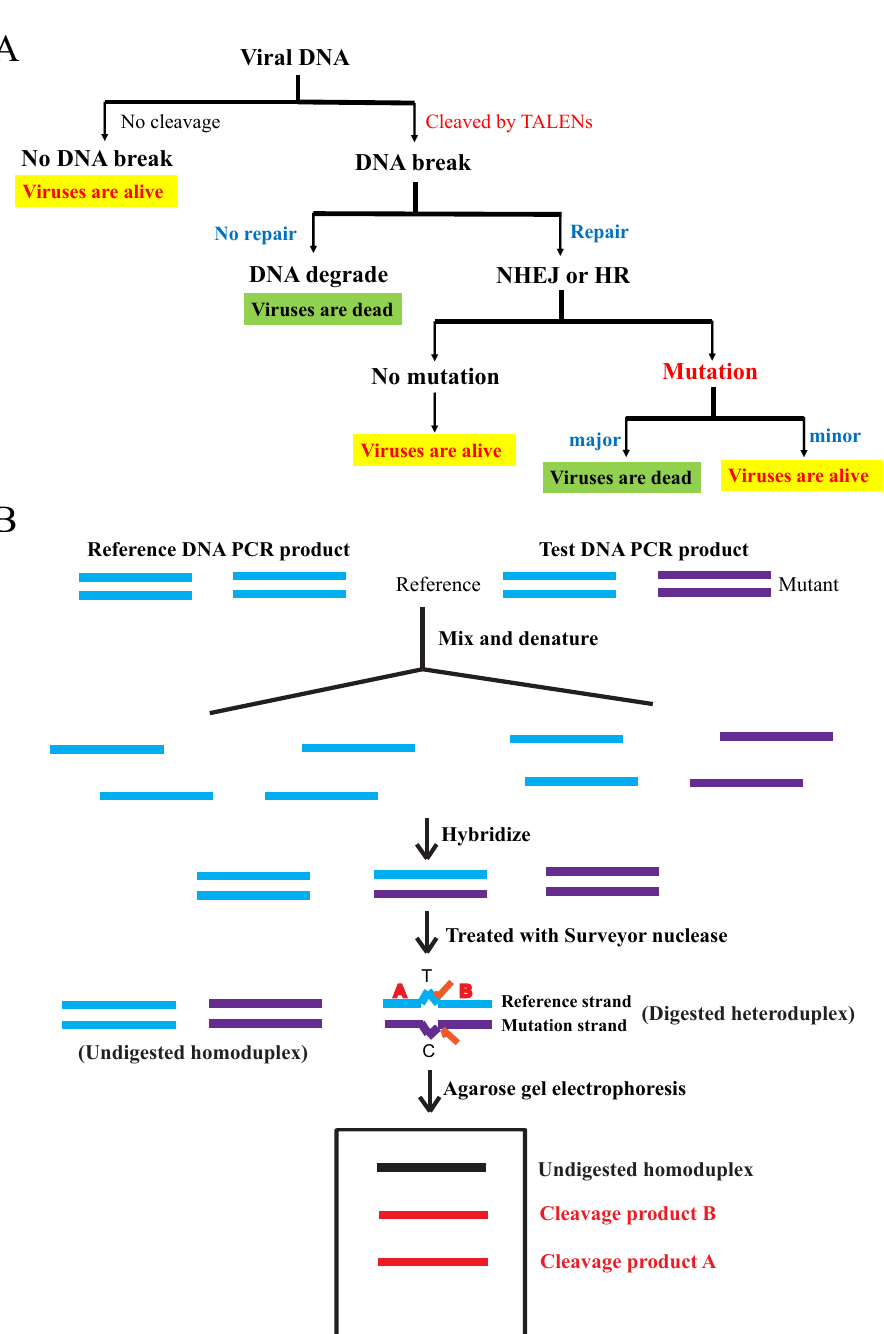
Figure 6. ( A ) Viral DNA targeting and cleavage: Once TALENs target and cleave the viral DNA, they will create a double stranded break (DSB). Either repaired by homologous recombination (HR) or non-homologous end joining (NHEJ), a mild mutation such as mismatch may appear. If viral DNA is mutated seriously or not repaired, viruses will be dead (highlighted in green). Viruses without cleavage, viruses without mutations, and viruses only with mild mutations are all alive (highlighted in yellow). ( B ) Surveyor nuclease mutation detection assay: Total DNA of all alive viruses are